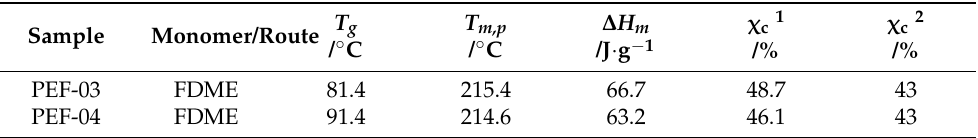
Table 2. Thermal and structural properties of the synthesized PEF-polymers after SSP as determined by differential scanning calorimetry (DSC) and XRD. T g : glass transition temperature; T m,p : melting peak temperature; ∆ H m : melt enthalpy; χ c : crystallinity.